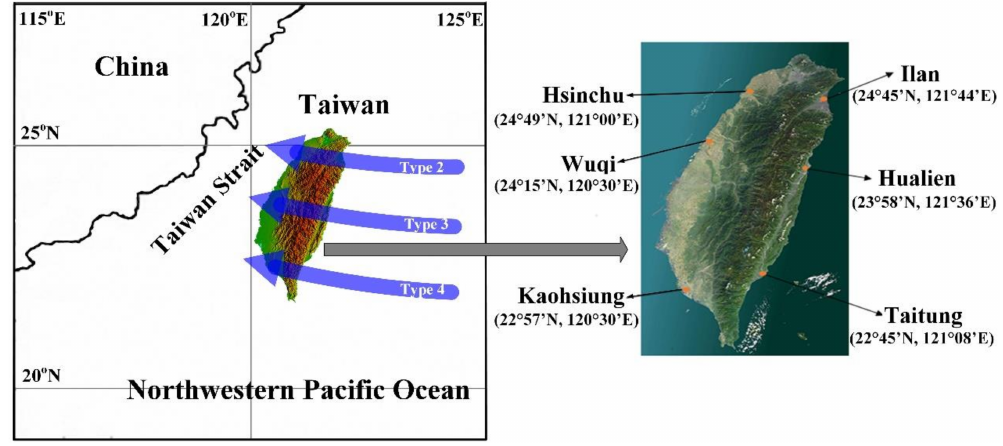
Figure 1. Typhoon track types and location of